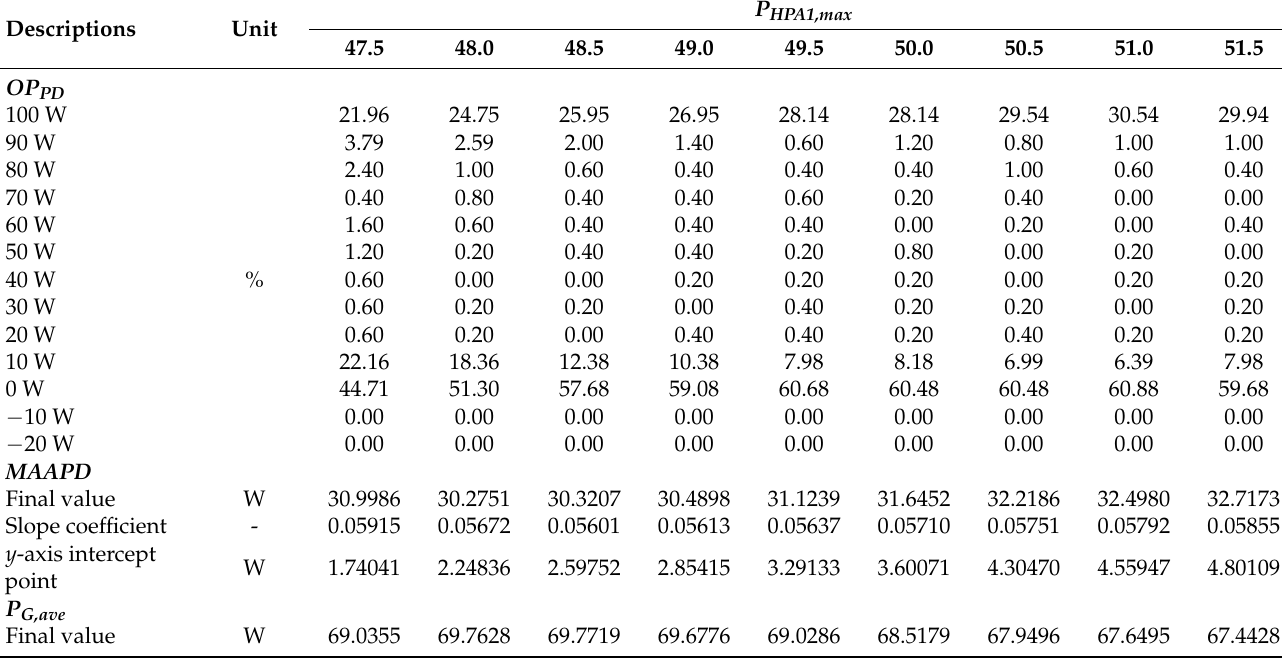
Table 4. The detailed findings of the P HPA 1, max effects on the the P G , imp